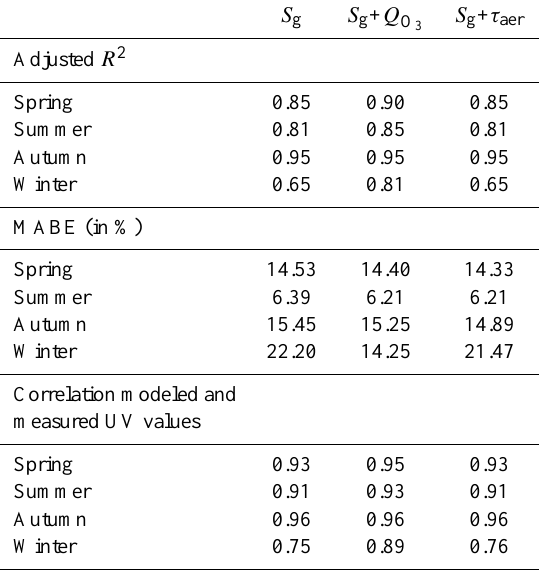
Table 11. Results of MLR analysis with only S g , S g combined with Q O and S g combined with τ aer as explanatory 3